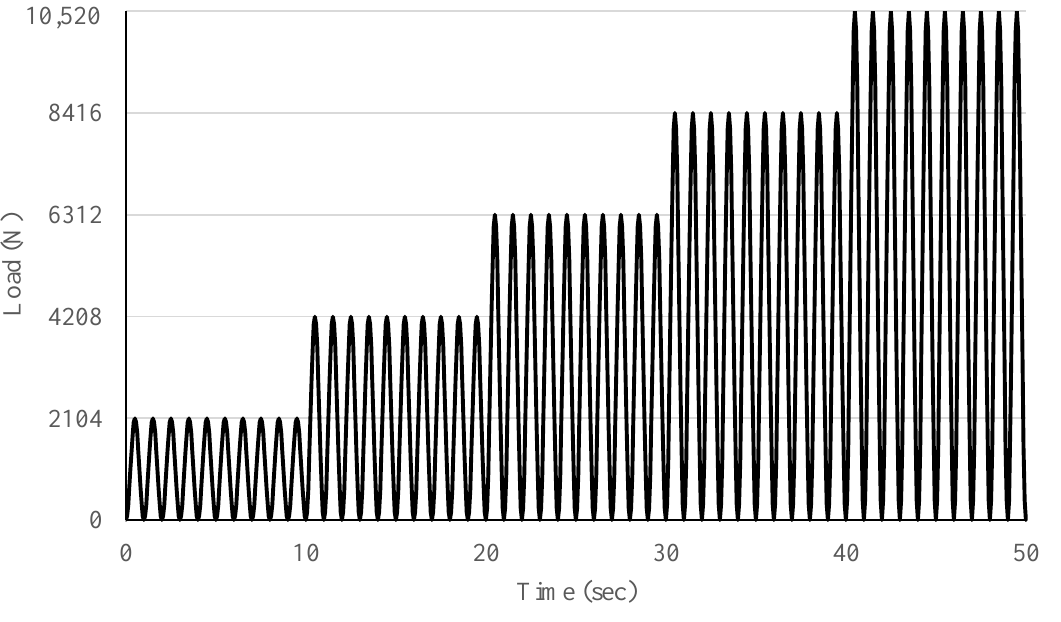
Figure 7. Cyclic load sequence for uplift test.